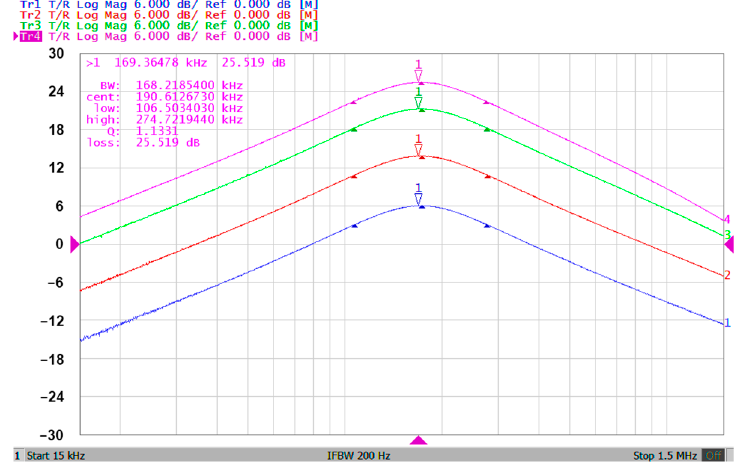
Figure 29. The measured magnitude responses of the V BP5 when g m2 was varied.